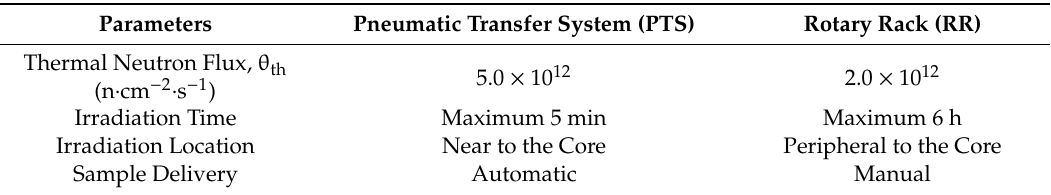
Table 2. Neutron activation protocols using pneumatic transfer system (PTS) and rotary specimen rack (RR)